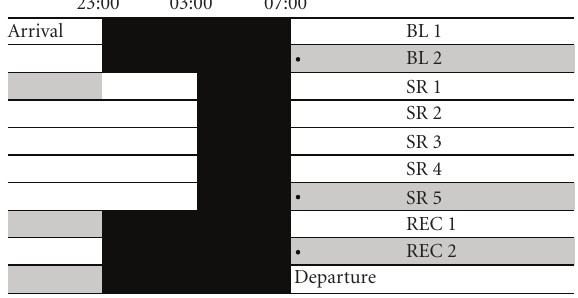
Figure 1: The experimental protocol. After two nights of 8h sleep (baseline BL), sleep is restricted to 4 h per night for 5 subsequent days (sleep restriction, SR), followed by three nights of 8h recovery sleep (REC). Profile days are shaded in grey. Bullet points indicate the taking of blood samples and rating of subjective